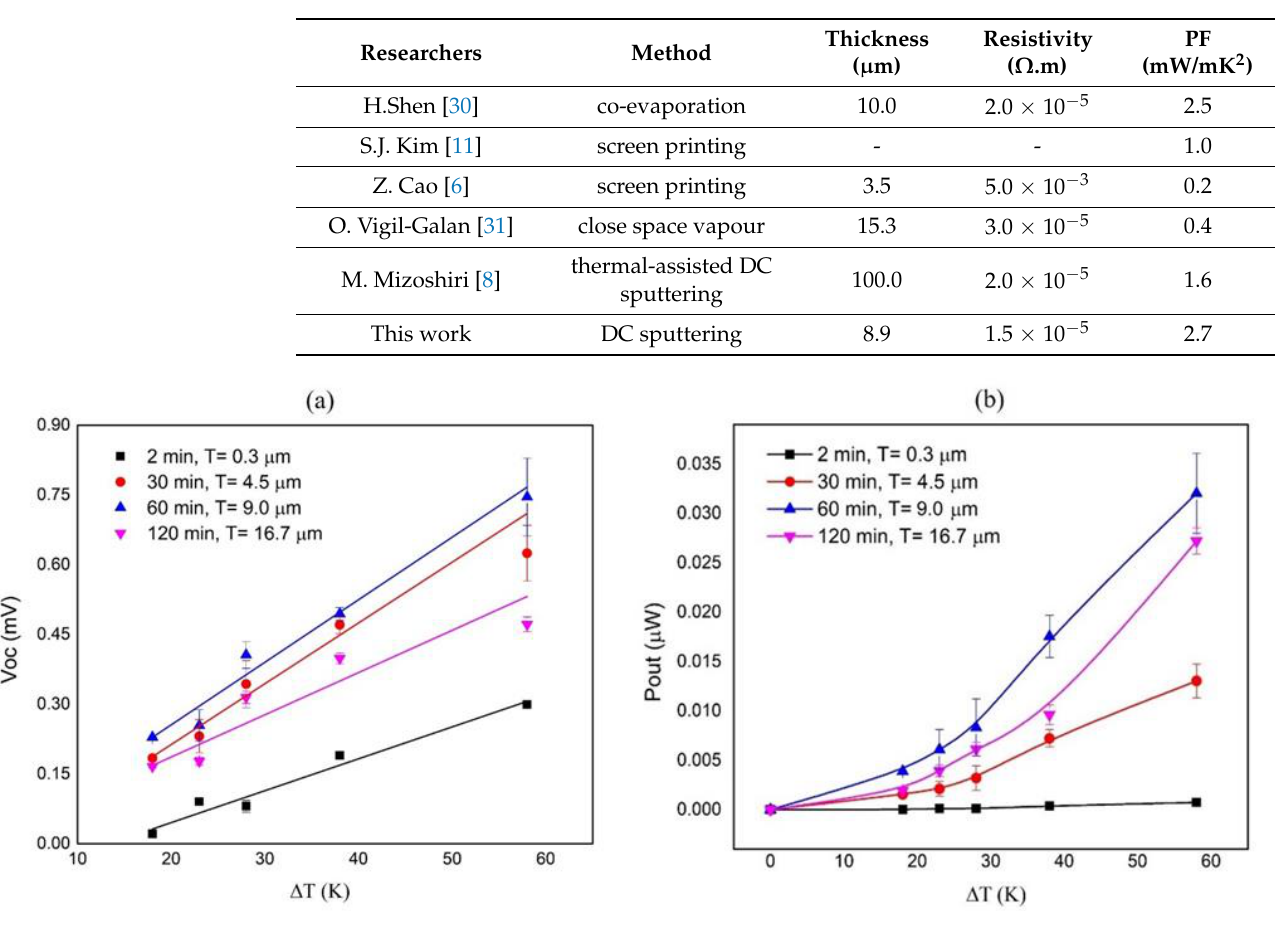
Table 2. Comparison of the thermoelectric properties of deposited Sb 2 Te 3 films in this work and other studies.